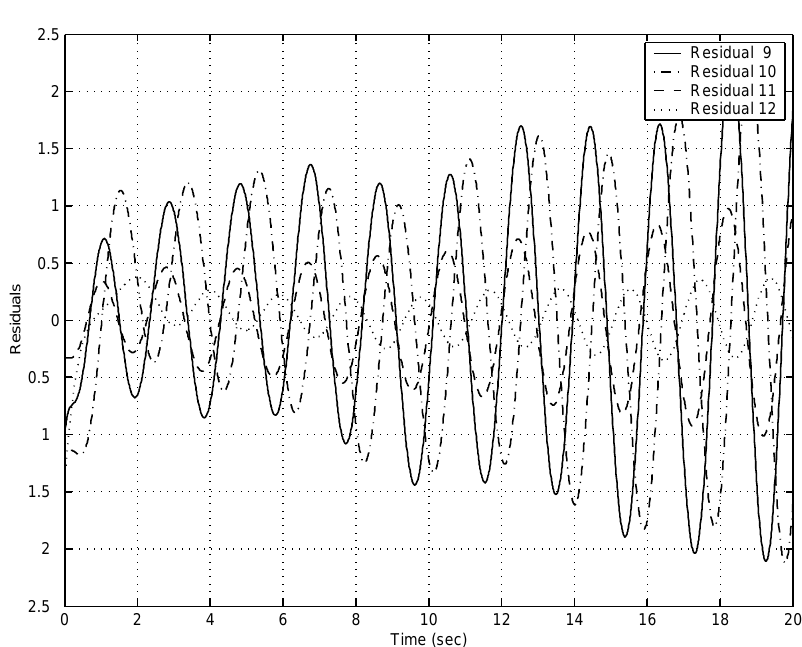
Fig. 16. Residuals 9–12 for 8 mode simulation with δ 1 = 0 . 01